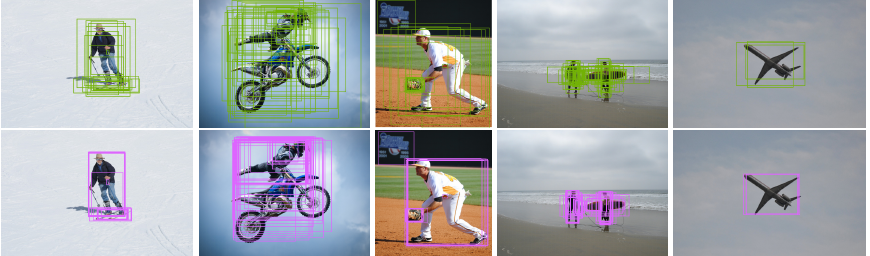
Figure 3. box rpn ( top ) vs. box det ( bottom ). The distributions of samples are intuitively different, and the regressed box det have higher IoU with objects than box rpn